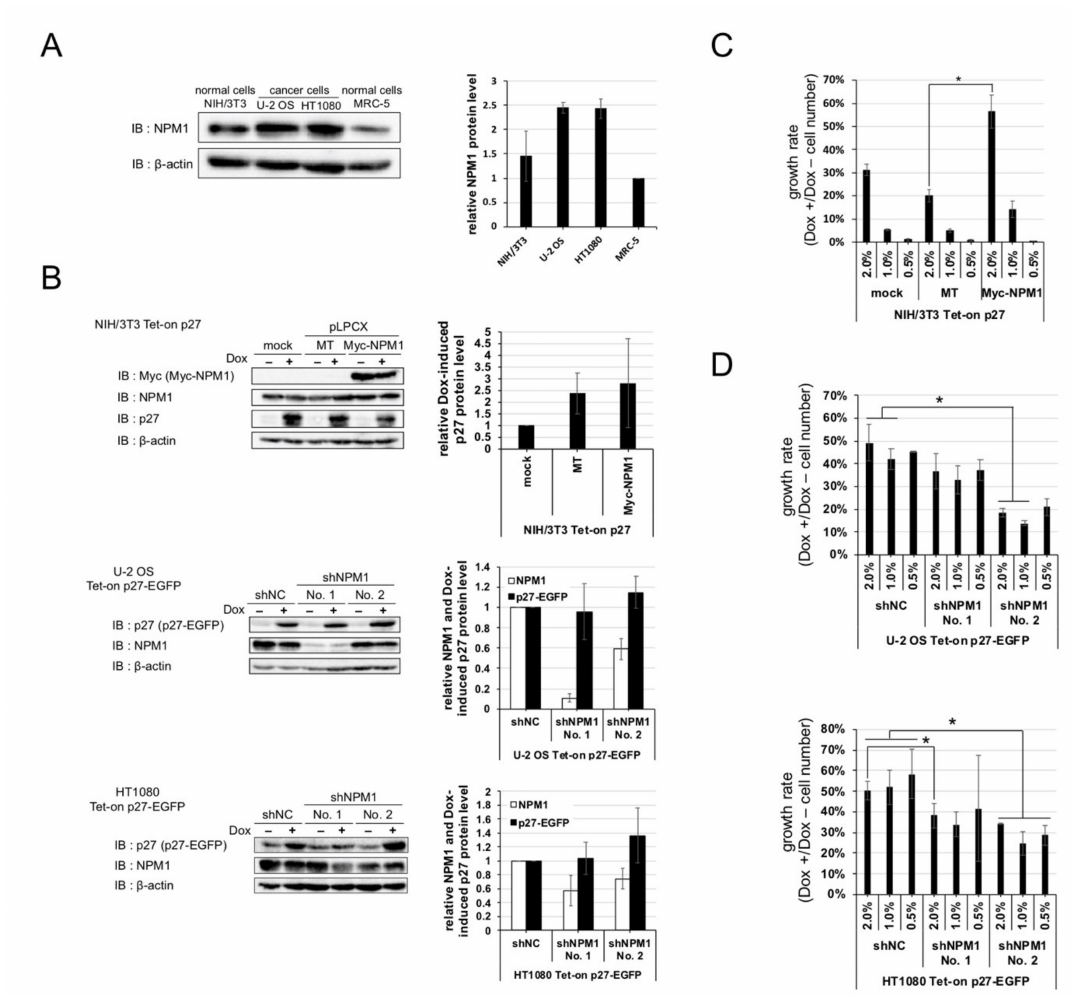
Figure 3. Nucleophosmin isoform 1 (NPM1) suppresses the function of p27 in vitro. ( A ) (left) Expressions of NPM1 protein in human cancer cell lines (U-2 OS and HT1080) and normal cell lines (murine NIH / 3T3 and human MRC-5) were detected by Western blot analysis using antibodies against NPM1 and control β -actin. (right) The relative expression levels of NPM1 (normalized with β -actin) in three cell lines are plotted (MRC-5 = 1); ( B ) (left) Expressions of NPM1 and p27 in NIH / 3T3 cells carrying Dox-inducible p27 and overexpressing NPM1 (top) and U-2 OS and HT1080 cells carrying Dox-inducible p27 and expressing NPM1 shRNAs (middle and bottom) were detected by Western blot analysis using antibodies against p27, NPM1, and control β -actin (mock, no vector; MT, Myc-tag only expression vector; Myc-NPM1, Myc-tagged NPM1 expression vector; and shNC, negative control shRNA). The relative expression levels of p27 and / or NPM1 (normalized with β -actin) in the three cell lines are plotted in the right (mock or shNC = 1); ( C ) Proliferation assay for NIH / 3T3 Tet-on p27 cells with or without NPM1 overexpression. The cells were seeded at low densities (1%, 3 × 10 3 cells per 35 mm dish), cultured for one week with or without 10 µ g / mL Dox, and counted. Growth rate is the division of the Dox + cell number by the Dox–; ( D ) Proliferation assays for U-2 OS (top) and HT1080 (bottom) Tet-on p27-EGFP cells with or without NPM1 knockdown. * 0.01 < p <